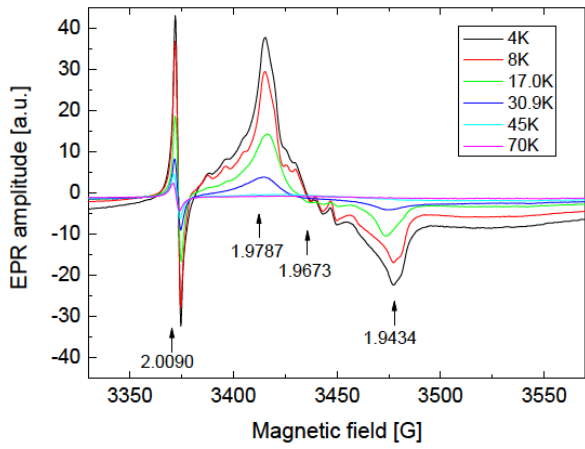
Figure 16: Low temperature EPR spectra of B-800 sample (narrow N and broad asymmetric BLT